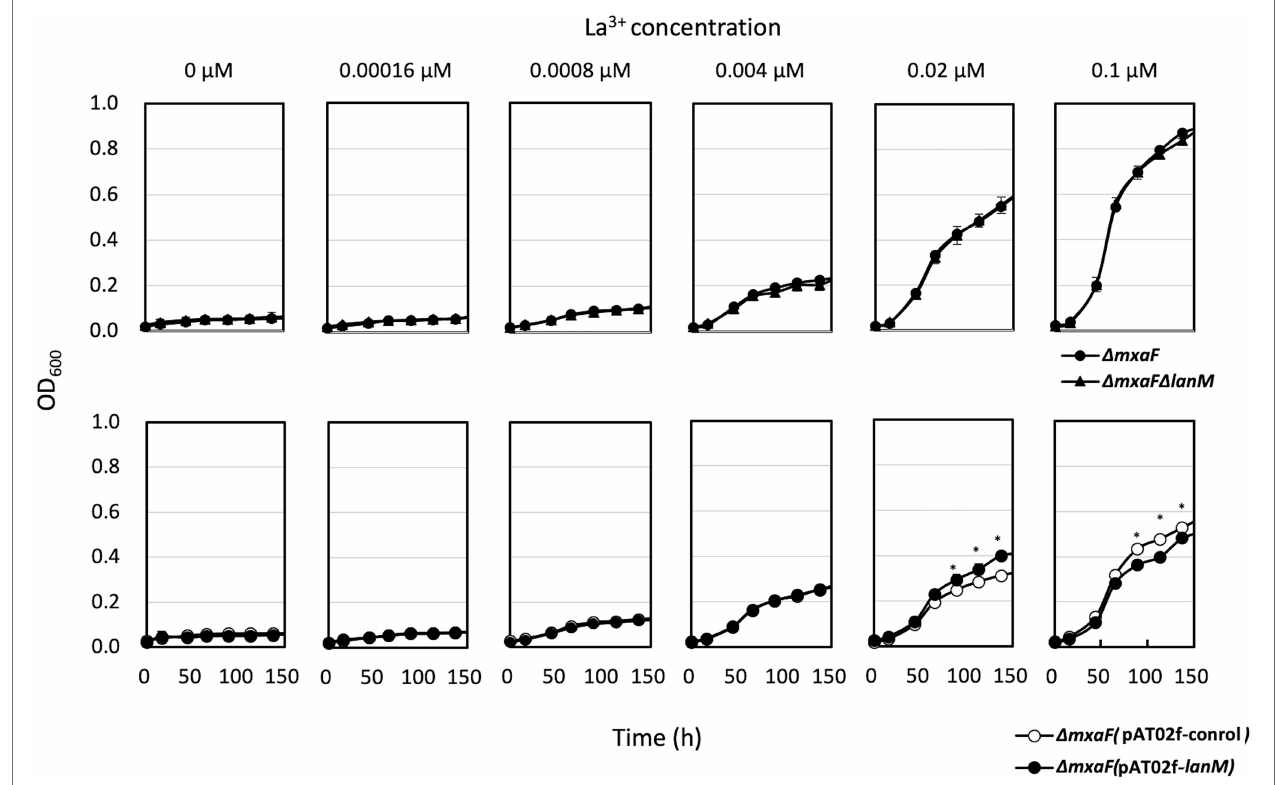
FIGURE 4 | Upper panel: Growth of Δ mxaF (filled circles) and Δ mxaF Δ lanM (triangles) on methanol in the presence of limited concentrations of La 3+ . Lower panel: Growth of Δ mxaF (pAT02f; open circles) and Δ mxaF (pAT02f-lanM; filled circles) on methanol in the presence of limited concentrations of La 3+ . Data are presented as the mean value ± standard deviation (SD; n = 3). The data were analyzed with two-way ANOVA followed by Sidak’s multiple comparisons test. * p <